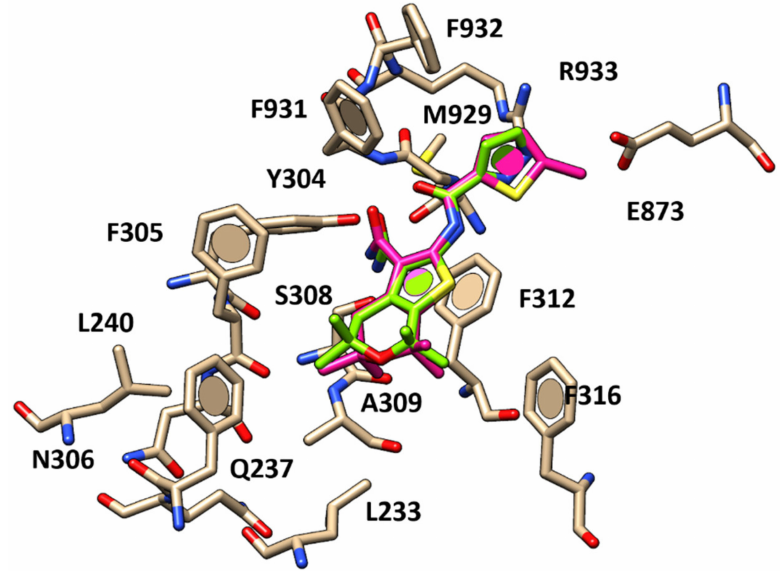
Figure 6. Docking positioning of compound 6 ( C atom; deep pink) compared to that of compound 11 ( C atom; green) within the human CFTR protein.